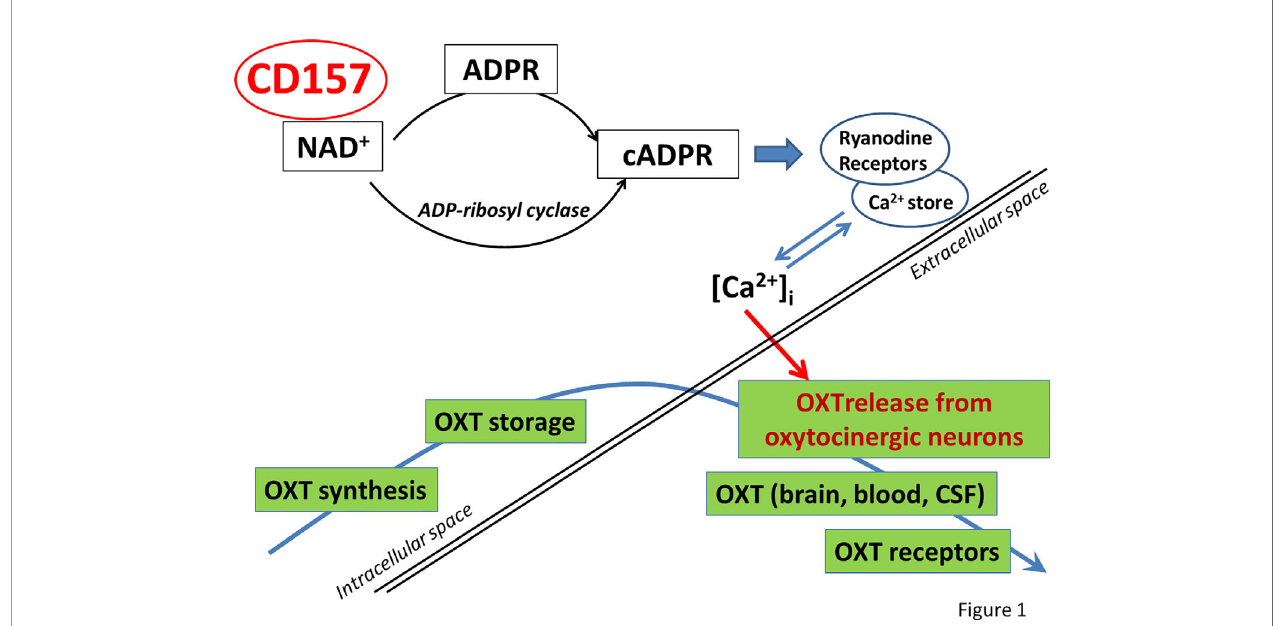
FIGURE 1 | Model illustrating the potential role of CD157 in oxytocin release. CD157 catalyzes NAD+ hydrolysis and synthesis of cADPR, then cADPR acts at Ryanodine receptors expressed in intracellular Ca 2+ stores to initiate [Ca 2+ ] i release to cytosole. As a result, OXT is secreted from the cell into the blood and brain tissue. ADPR, ADP-ribose; cADPR, cyclic ADP-ribose; OXT,